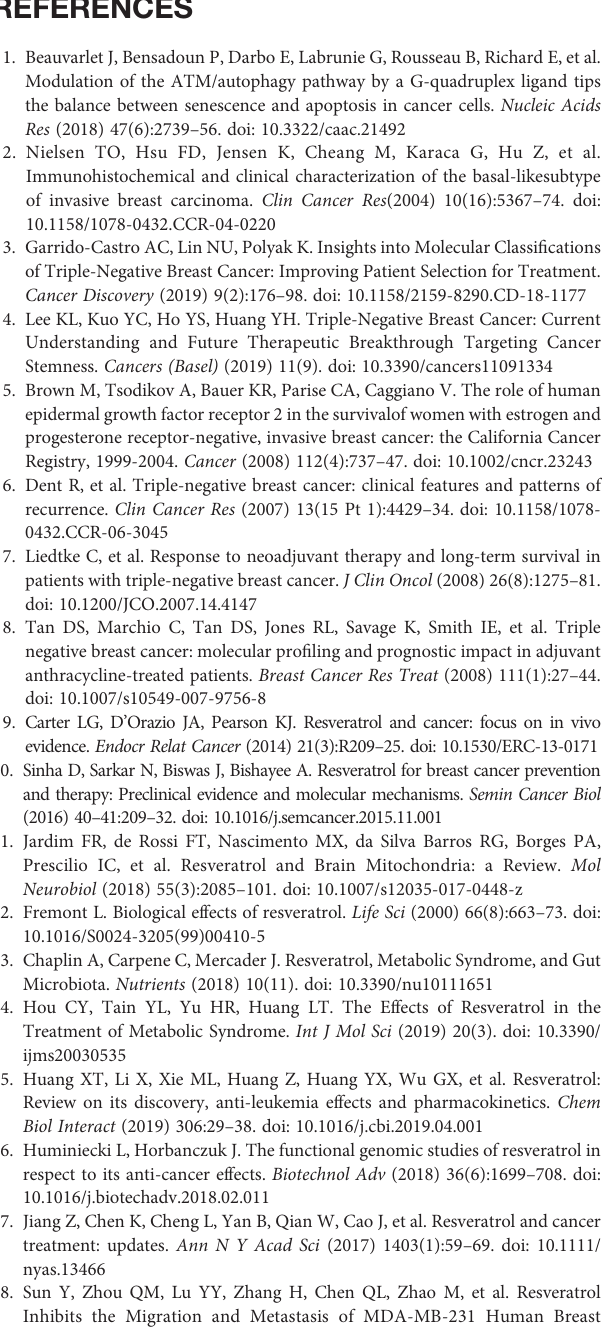
Supplementary Table 5 | Rescue experiment of POLD1 overexpression. Supplementary Table 6 | The result of CCK8 detection of cell viability after rescue experiment. Supplementary Table 7 | Weight and volume of nude mouse models after RSV